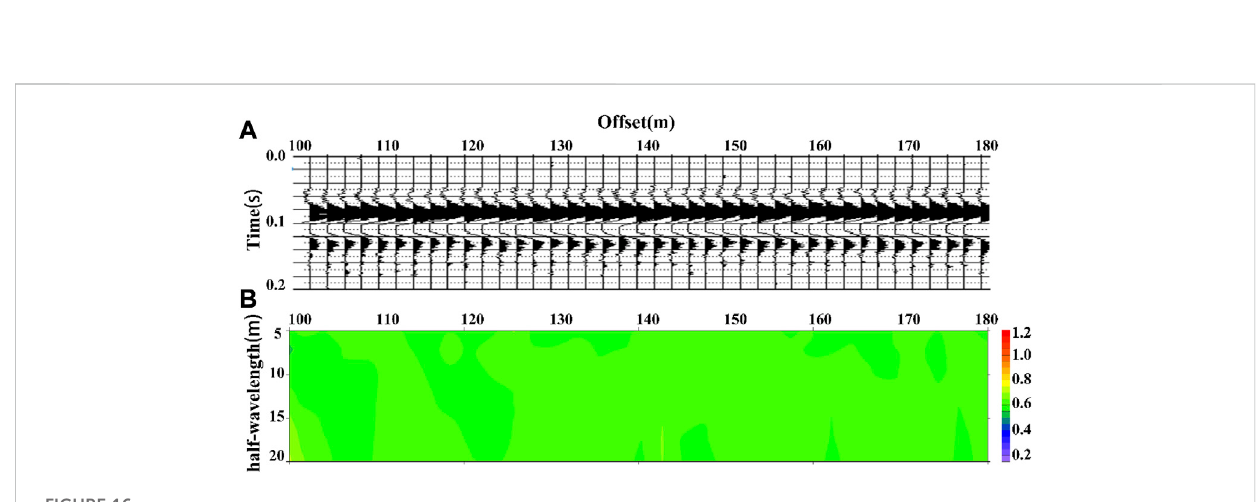
The processing results are shown in Figure